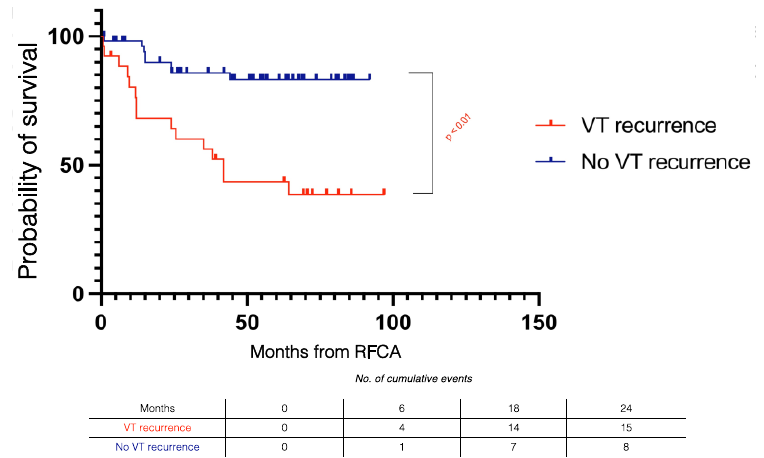
Figure 4. Kaplan–Meier survival curves stratified by VT recurrence during follow-up in electrical storm patients. RFCA = radiofrequency catheter ablation.